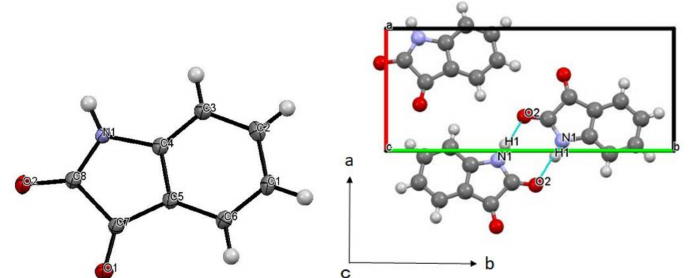
Figure4. ( left )Molecularand( right )crystalstructureof CA4 . Selectedbonddistances[Å]andangles[ ◦ ]: O1-C7 = 1.2113(16), O2-C8 = 1.2215(16), N1-C8 = 1.3544(17), N1-C4 = 1.4102(16), C5-C7 = 1.4658(17), C7-C8 = 1.5670(18), C8-N1-C4 = 111.22(11), C3-C4-N1 = 127.32(12), C5-C4-N1 = 111.04(11), O1-C7-C5 = 131.17(12), O2-C8-C7 = 126.03(12), N1-C8-C7 = 105.95(10).